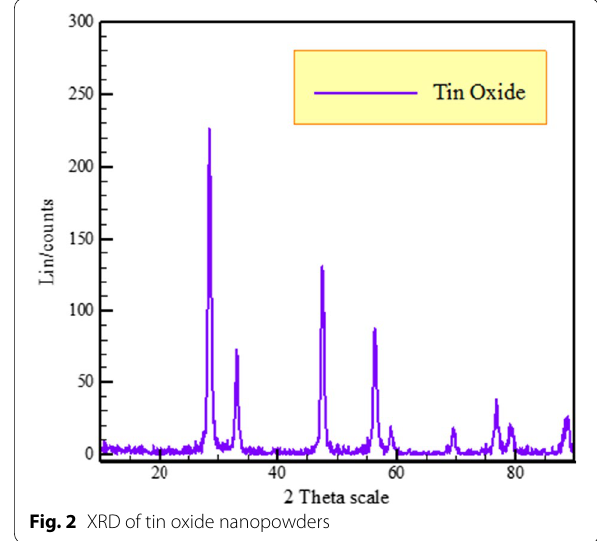
Fig. 2 XRD of tin oxide nanopowders